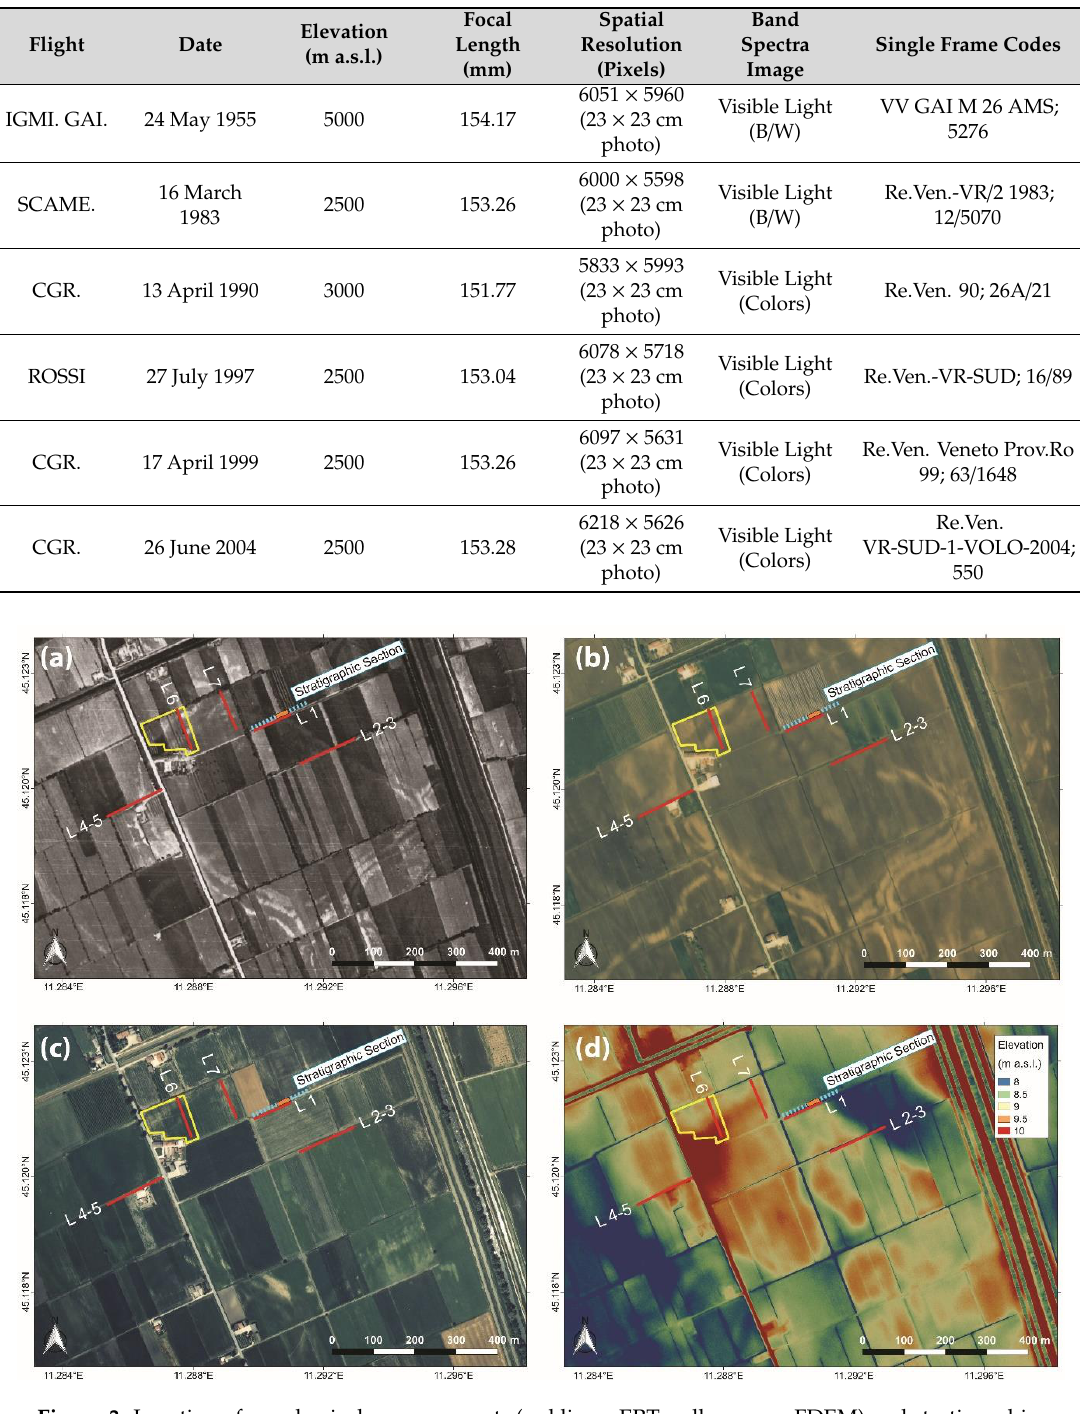
Table 1. List of aerial photo frames used for the photo interpretation.